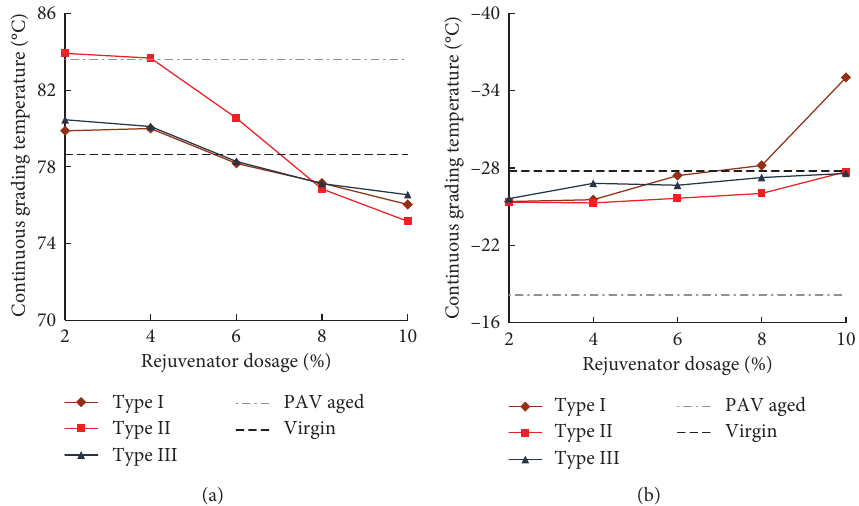
Figure 6: Superpave PG of different rejuvenated SBSMA. (a) High-temperature continuous grade; (b) low-temperature continuous